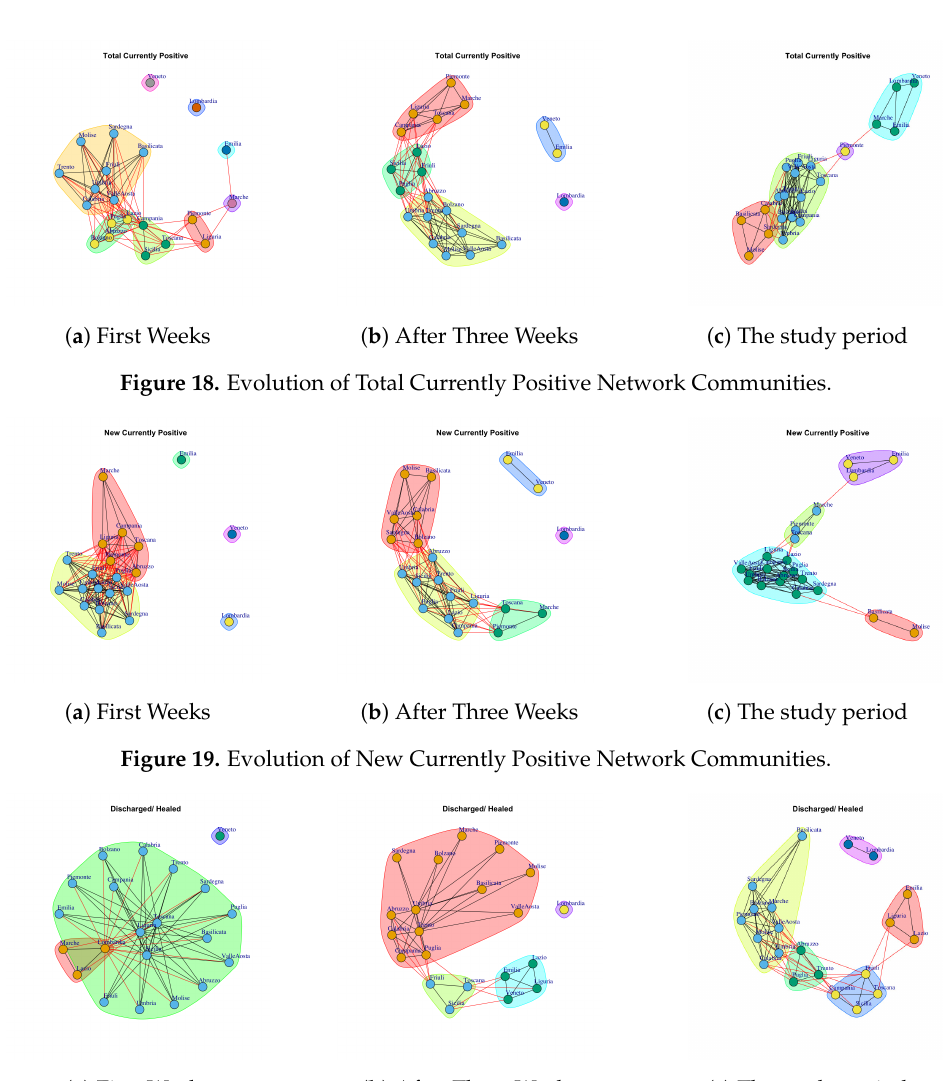
Figure 17. Evolution of Home Isolation Network Communities.